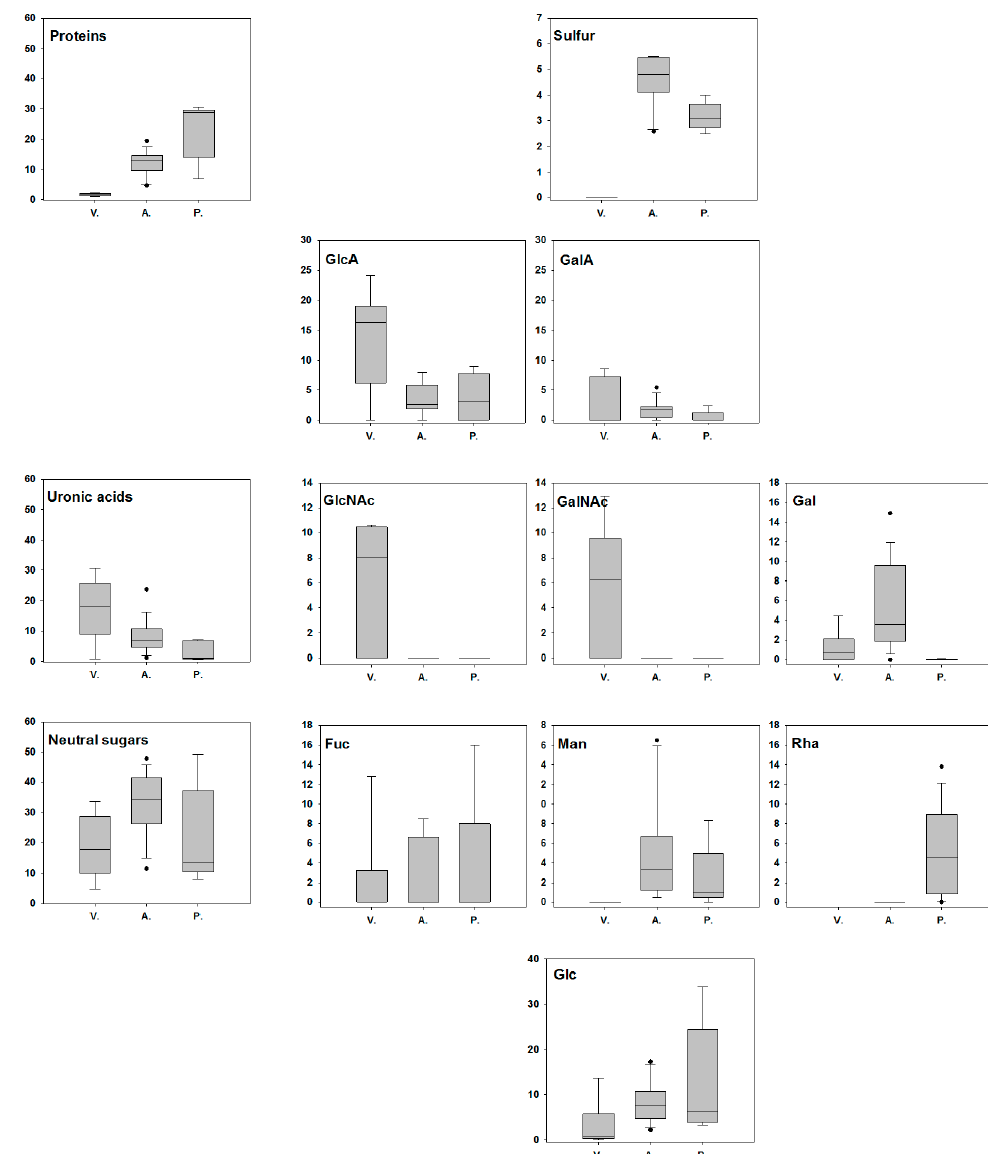
Figure 4. Box plot representation of the composition of EPS (% w / w ) as a function of strain phylogeny: V. stands for Vibrio sp., A. for Alteromonas sp. and P. for Pseudoalteromonas sp. In the boxes, the 25th, 50th, and 75th percentiles are indicated by the bottom, middle and top lines, respectively. Whiskers show the 10th and 90th percentiles. Individual dots are the outliers. EPS were extracted from 100 mL culture broth and analyzed by colorimetric assays (sulfur, proteins, uronic acids, and neutral sugars) and GC (monomers).